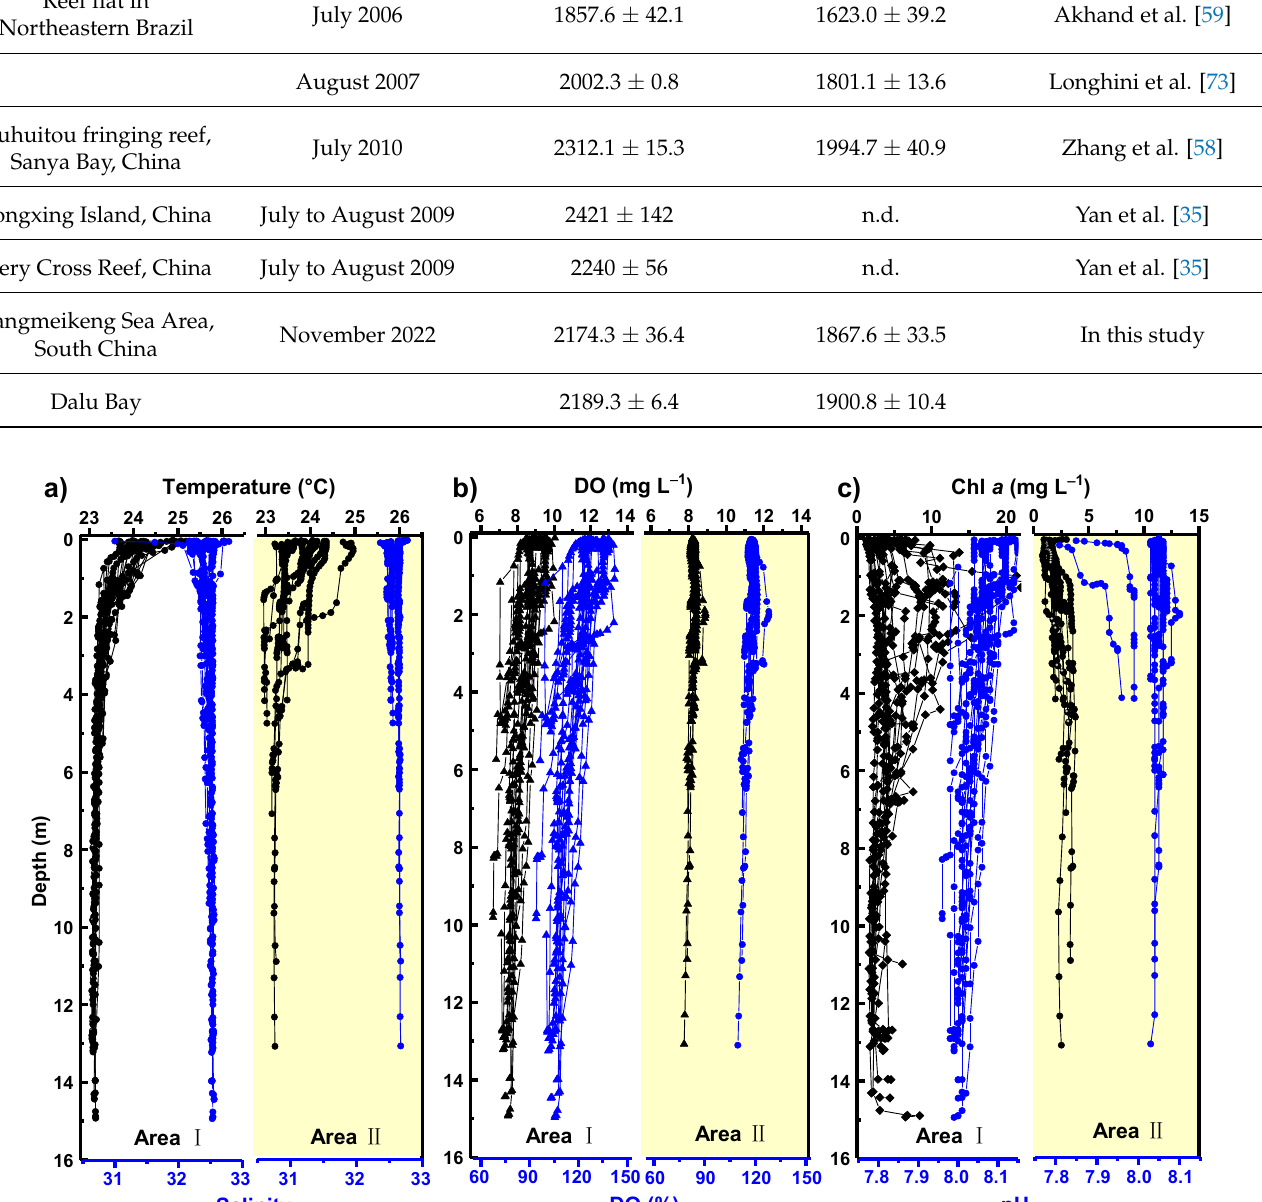
Figure A2. Distribution characteristics of temperature ( a , b ), salinity ( c , d ), DO ( e , f ) and Chl a ( g , h ) in the surface and bottom water of Yangmeikeng Sea Area (Area I).